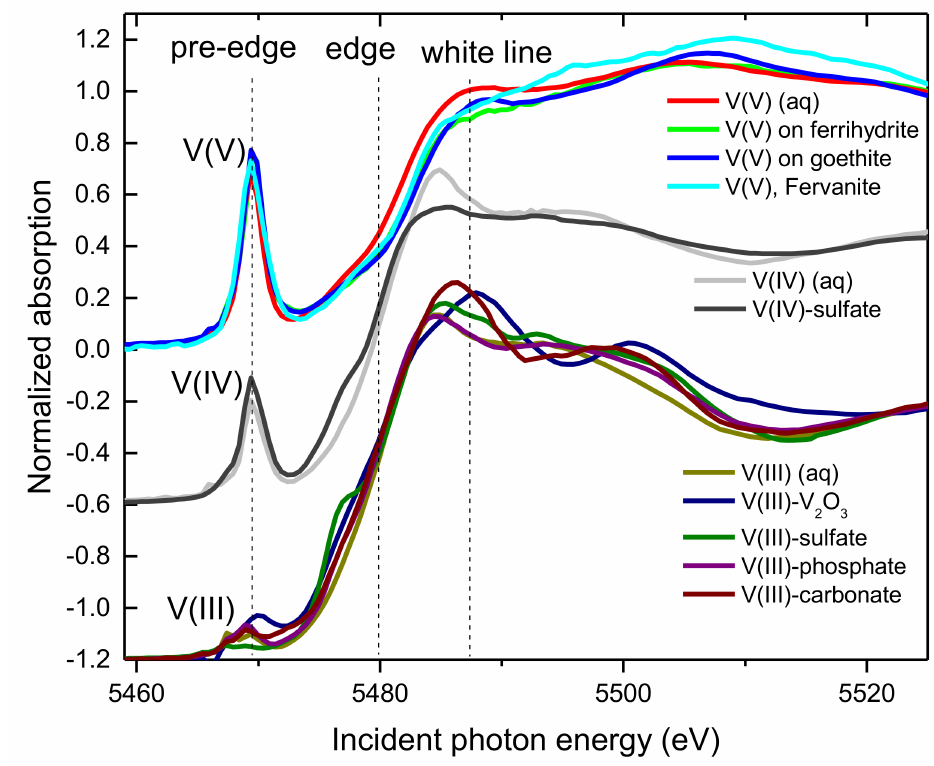
Figure 2. Comparisons of the V K-edge X-ray absorption near edge spectra (XANES) from the V standards. The spectra are grouped by V valence state and offset vertically. The vertical dashed lines indicate the approximate pre-edge, edge, and white line